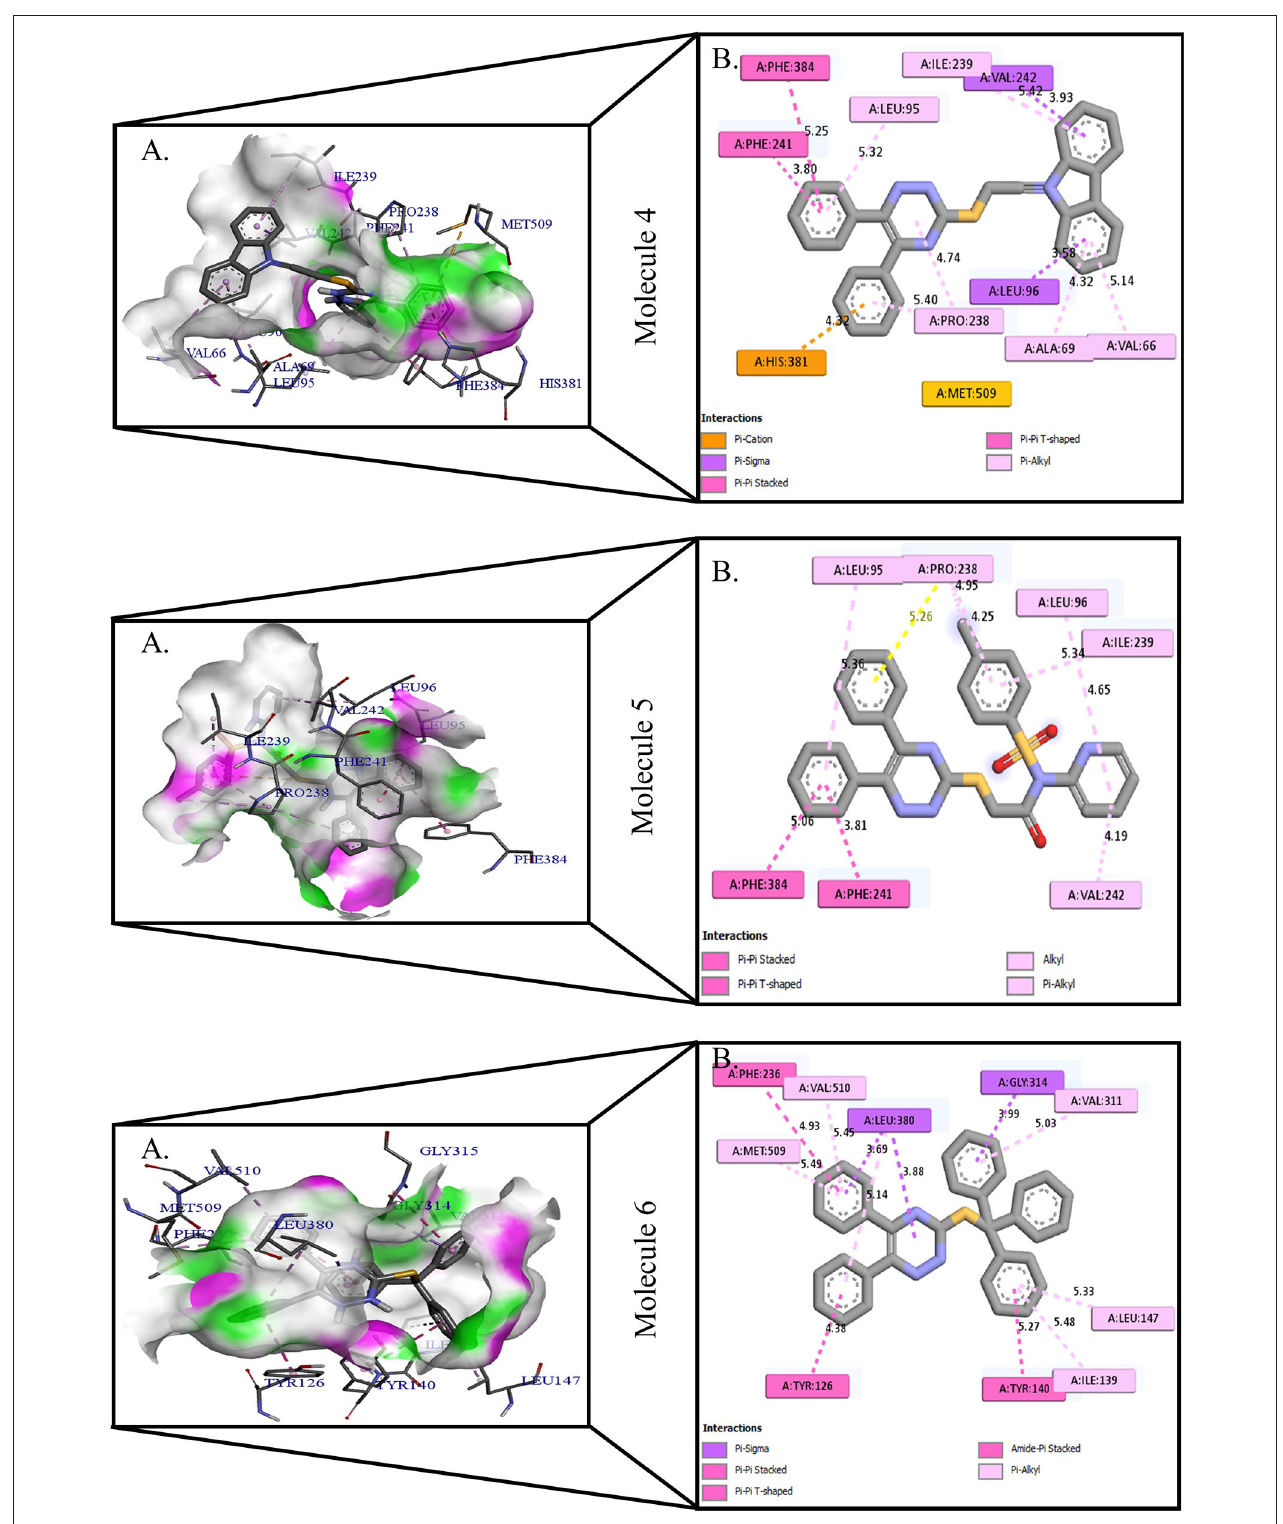
FIGURE 2 | Protein-ligand presentation of CYP51 with molecules 4, 5, and 6. (A) 3D receptor-ligand presentation, and (B) 2D receptor-ligand interactions.